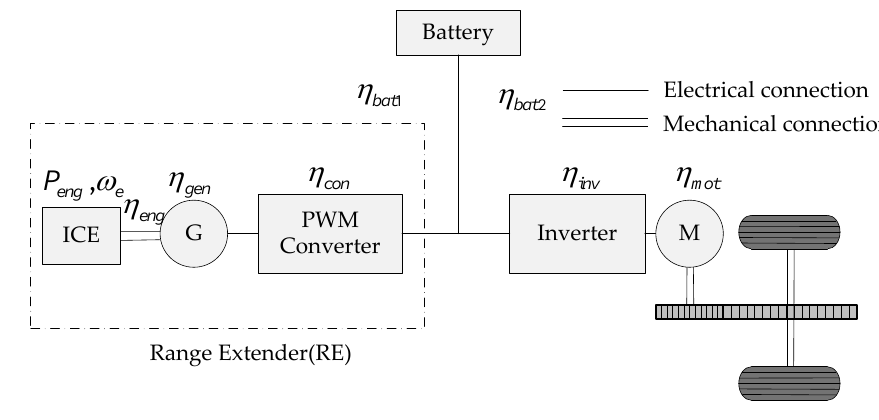
Figure 1. Block diagram for the architecture of an EREV.